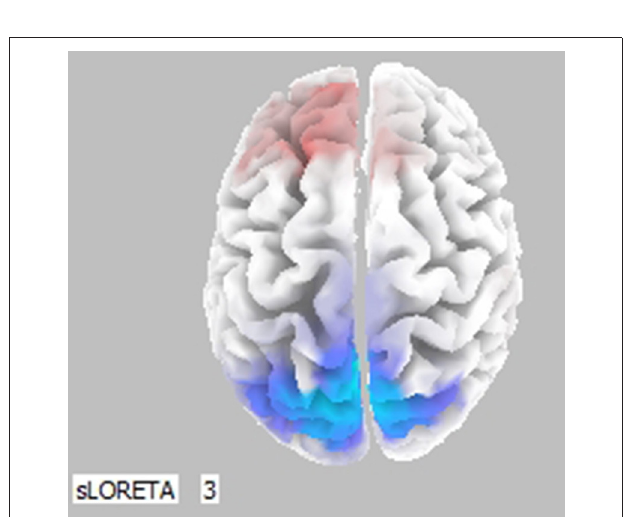
FIGURE 13 | Statistically significant cerebral activity was estimated by LORETA software in the Lower Alpha Band when two pieces of information were presented in (SP, BN) and in (0, SP + BN). Similar results were observed in the Upper Alpha Band. Orange areas suggest a significant increase in cortical activity for the first scenario (SP, BN) with respect to the other scenarios. Blue colors depict the